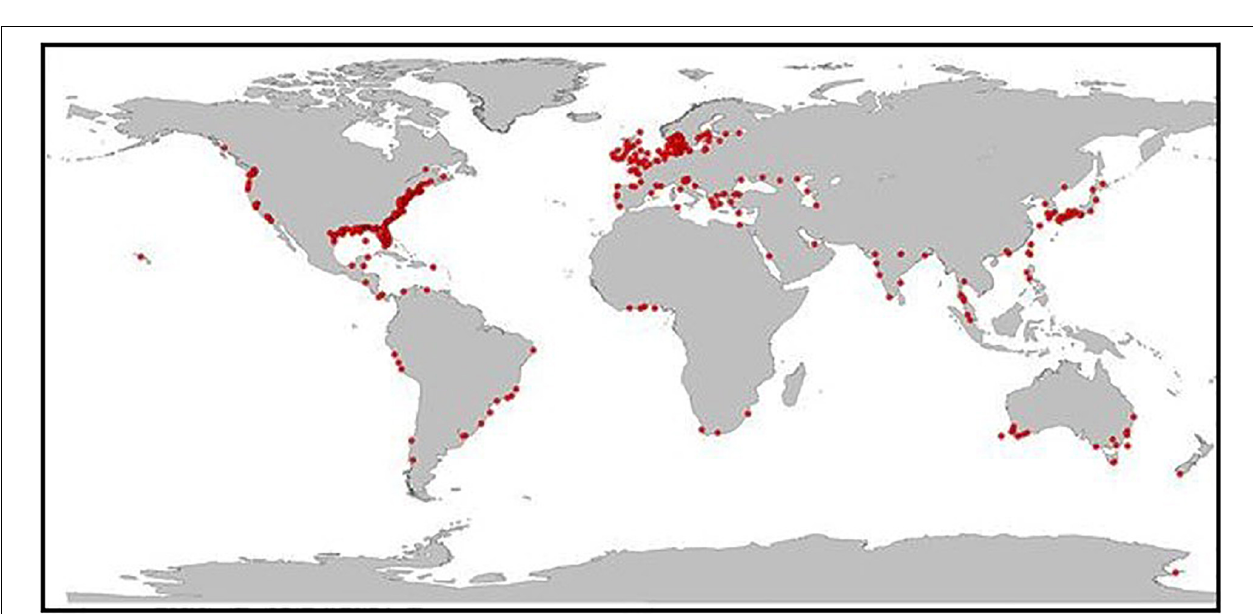
FIGURE 2 | Global distribution of eutrophic coastal marine ecosystems (adapted from Breitburg et al., 2018). Recent coastal surveys by the United States and the European Union found that 78% of U.S coastal waters and 65% of Europe’s Atlantic coastal waters exhibit symptoms of eutrophication.